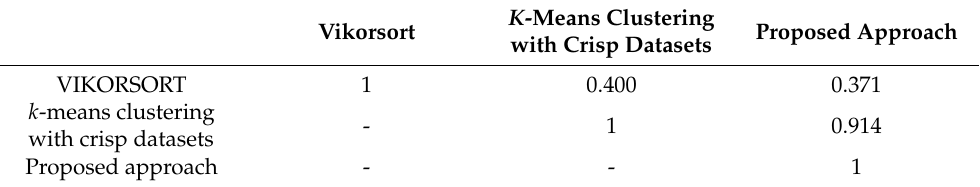
Table 16. Comparing the assignments of tourist sites to clusters with VIKORSORT, k -means clustering with crisp datasets, and the proposed approach based on S r .